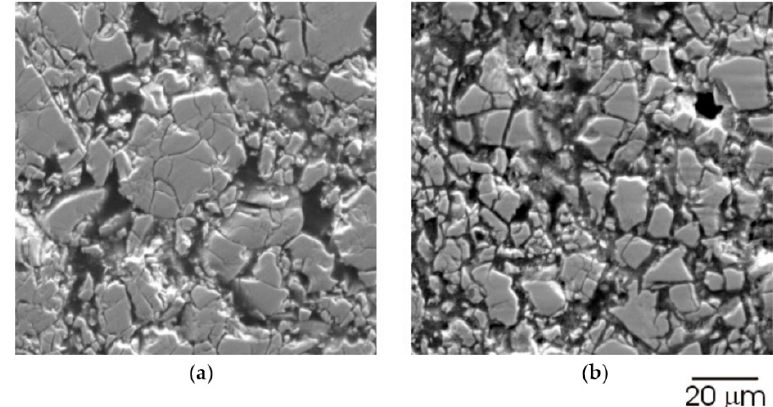
Figure 13. SEM cross-section micrographs of a C14 MH alloy at ( a ) 10th cycle, just after initial activation and ( b ) 450th cycle, at the end of cycle life.